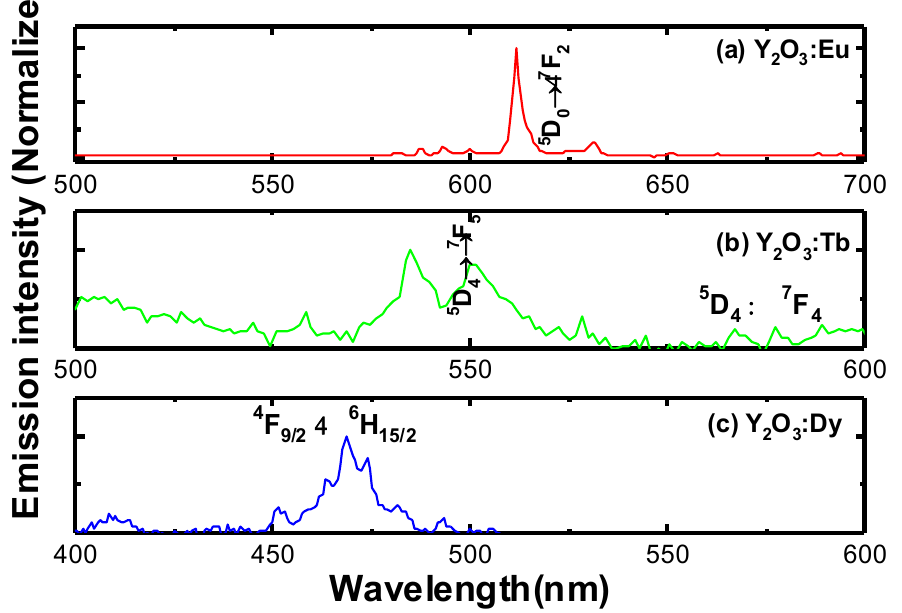
Figure 4. Luminescence spectra of ( a ) 0.05 mMol% Eu:Y 2 O 3, ( b ) 0.05 mMol% Tb:Y 2 O 3, and ( c ) 0.05 mMol% Dy:Y 2 O 3 nanophosphors.